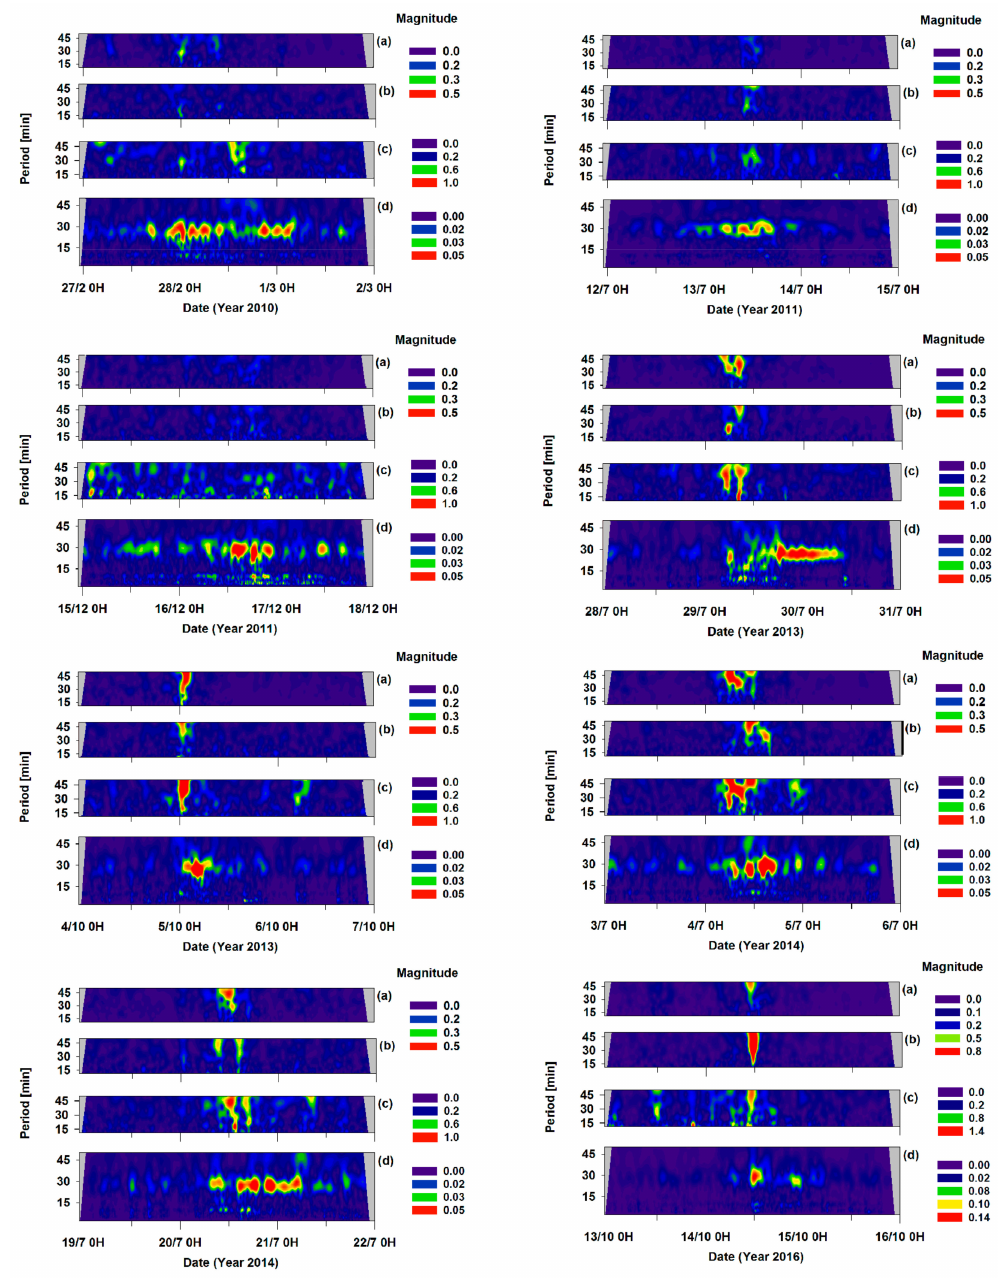
Figure 5. For each selected event, scalogram of: ( a ) Atmospheric pressure measured by the W1M3A observatory; ( b ) atmospheric pressure measured in the port of Genoa; ( c ) wind speed measured by the W1M3A observatory; ( d )